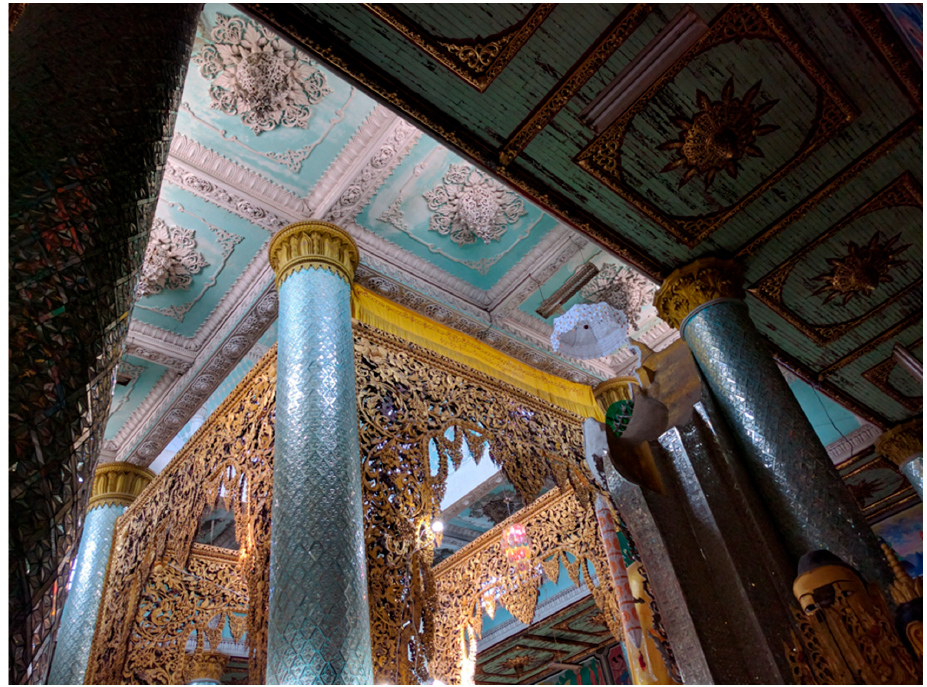
Figure 4. Photograph of the inside of the Arlein Nga Sint Pagoda.